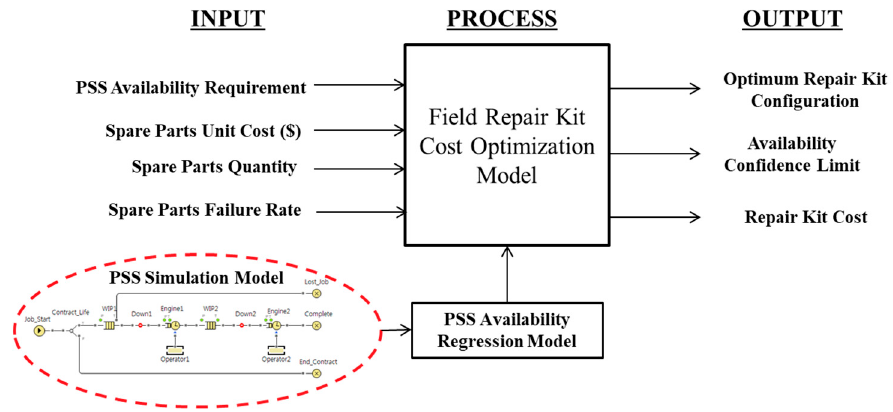
Figure 3. IPO diagram of the field repair kit cost optimization model.